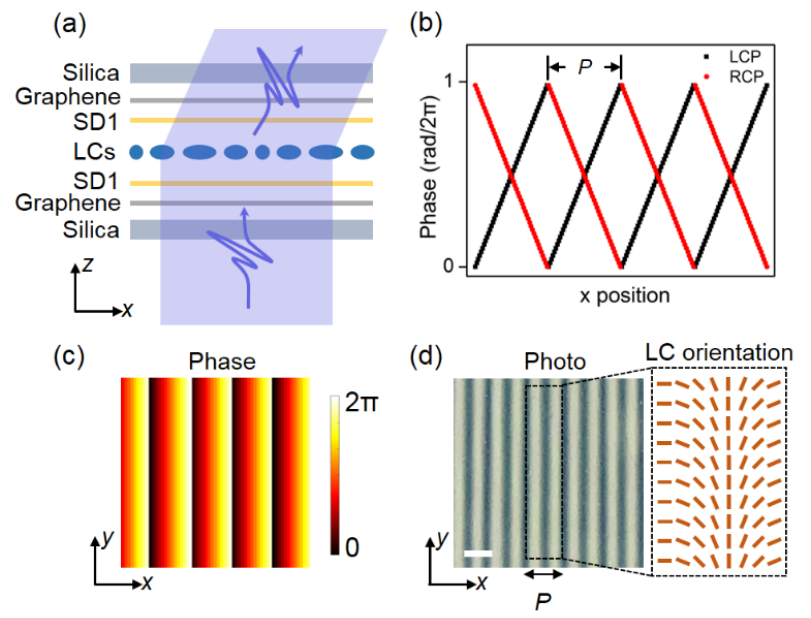
Figure 1. ( a ) Schematic of the beam deflector. ( b ) Required grating phase along the x -axis. ( c ) Phase distribution diagram of the designed grating. ( d ) Prepared LC sample under crossed polarizers and orientation distribution in the corresponding area.